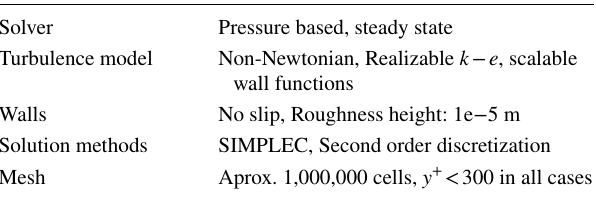
Fig. 5 Percentage of degradation of HPAM obtained in the tests of the valve with EOR-500 solution Table 2 Parameters employed in the CFD